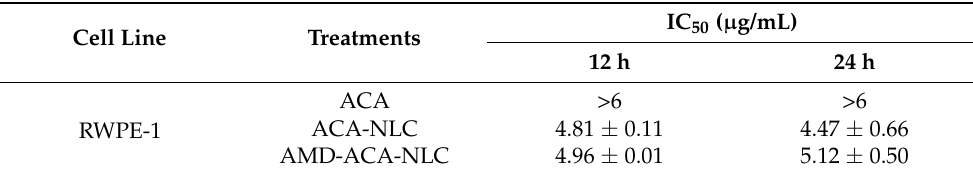
Table 2. IC 50 values of ACA, ACA-NLC, and AMD-ACA-NLC treatments on RWPE-1 cells. All data are expressed as mean ± SD of three independent replicates.